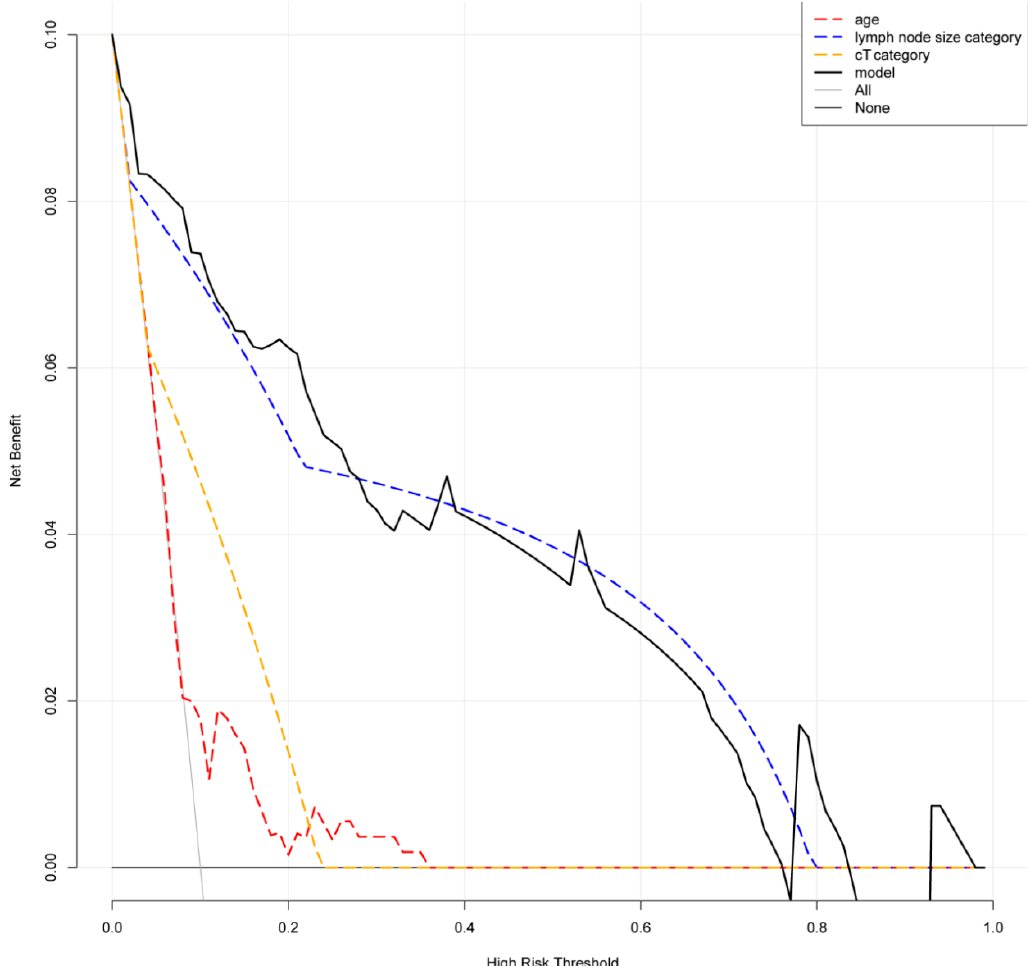
Figure 4. The DCA of this model showed a threshold probability of